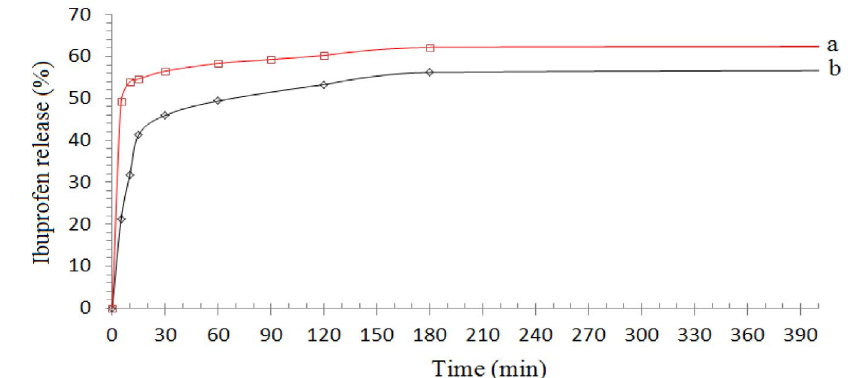
Fig. 7. Release profiles for 25 and 50% ibuprofen supported γ-alumina in SGF (a) γ-Al-IBU25 and (b)